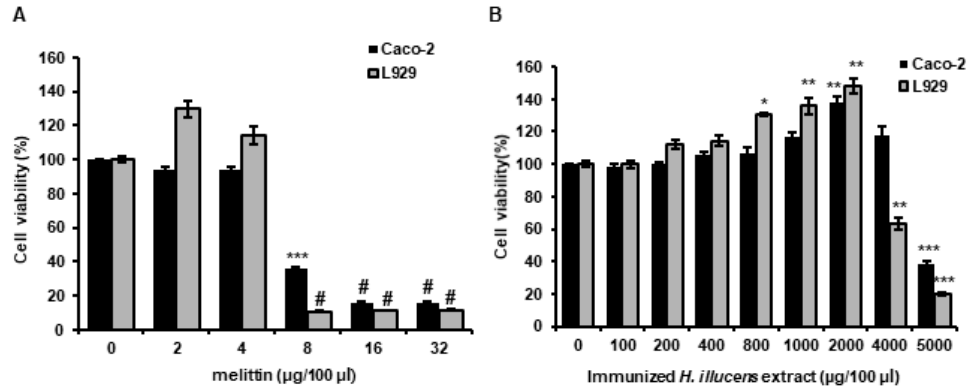
Figure 6. Evaluation of cytotoxic effects of melittin ( A ) or L. casei -immunized HIL extract ( B ). ( A , B ) 1 × 10 4 cells were seeded into wells, allowed to attach for 24 h, and then cultured with various concentrations of melittin or L. casei -immunized HIL extract for 24 h. The values of column graphs are presented as the mean ± S.D. *, **, *** and # indicate p < 0.05, p < 0.01, p < 0.005, and p < 0.001 vs. 0 µg/100 µL, respectively.